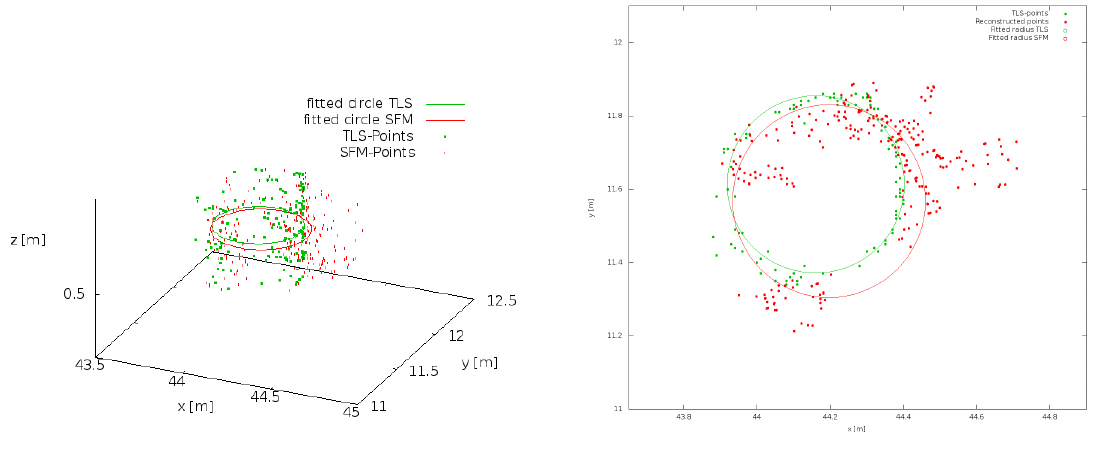
Figure 7: A 50[cm] slice of a TLS stem (green) and a recon- structed stem (red) and their corresponding fitted diameters projected on a